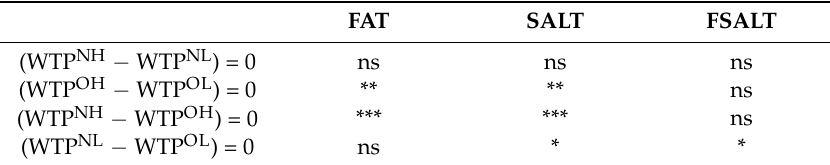
Table 4. Statistical significance from Poe Test across four